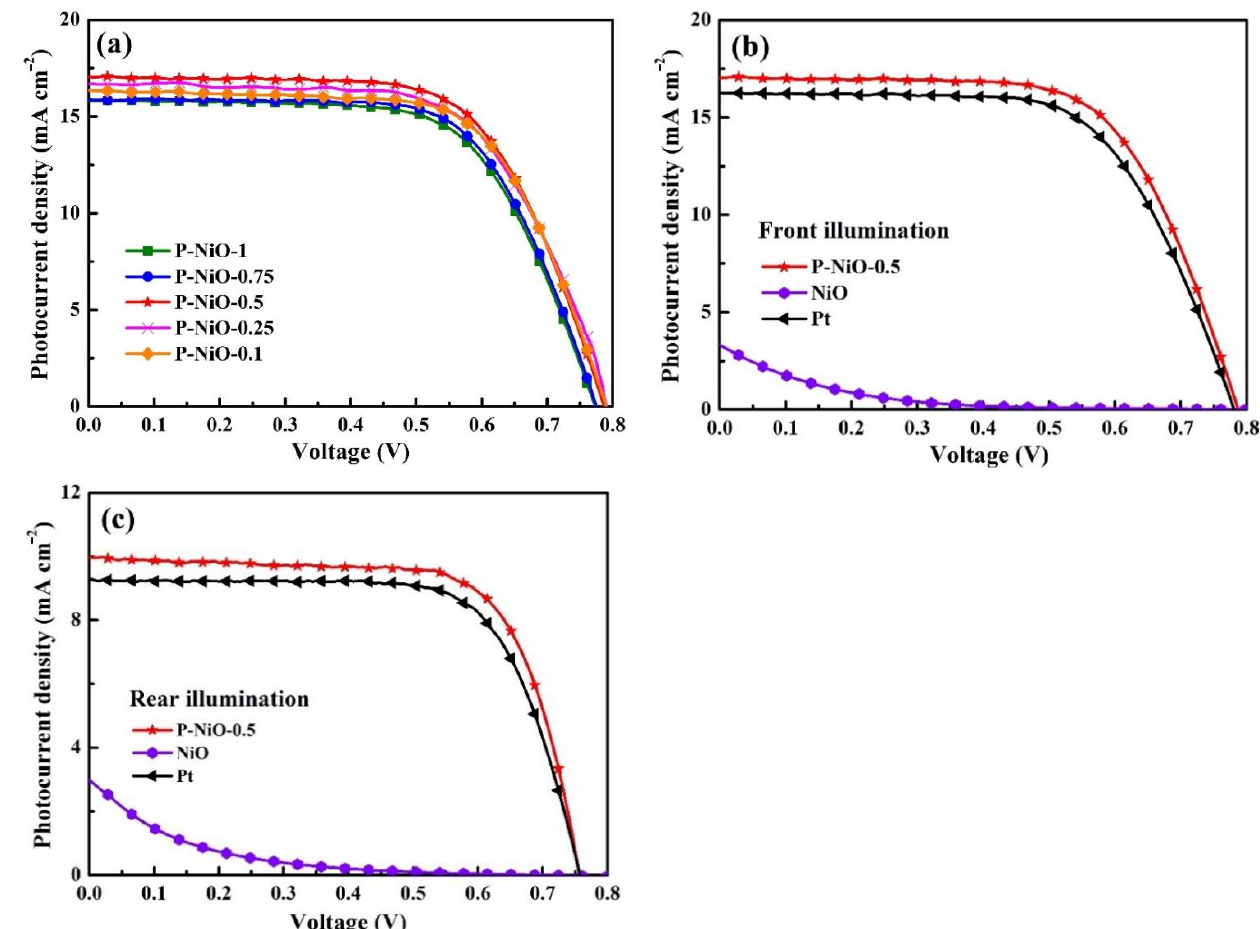
Figure 4. ( a ) DSSC photocurrent density-voltage curves having various P-NiO CE films illuminated in front at 100 mW cm − 2 (AM1.5G), ( b ) photocurrent density-voltage curves of the DSSCs with P-NiO-0.5, NiO and Pt CEs illuminated in front at 100 mW cm − 2 (AM1.5G) and ( c ) photocurrent density-voltage curves of the DSSCs with P-NiO-0.5, NiO and Pt CEs illuminated in rear at 100 mW cm − 2 (AM1.5G). Table 1. Photovoltaic parameters of the DSSCs with CEs having various P-NiO films, measured at 100 mW cm − 2 (AM1.5G) in front illumination. The standard deviation for the data is based on three cells.